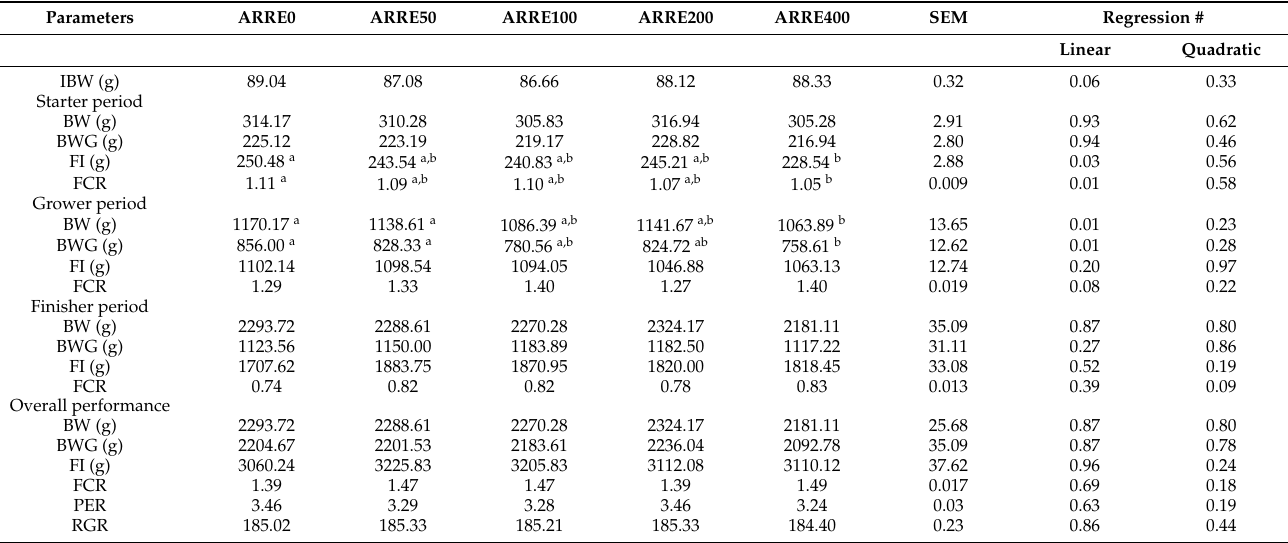
Table 2. The effect of dietary addition of ARRE on the growth of broiler chickens.